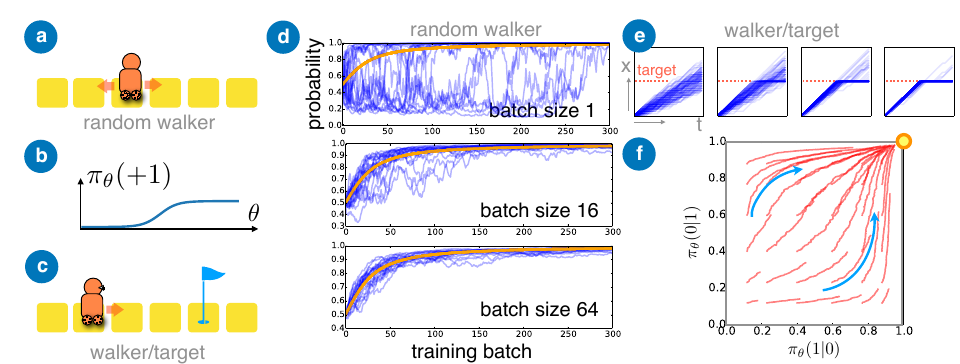
Figure 4: Simple illustrations of reinforcement learning. (a) A random walker moving either left or right in each time step, where the reward will be determined according to the distance covered to the right. (b) Dependence of the probability π (+ 1 ) for moving right on the policy parameter θ . (c) The walker / target example, θ where the walker has to learn to stop when on target. (d) Learning progress for the random walker, using policy gradient: we display the probability to move right (which should ideally converge to 1). Increasing batch sizes lead to smoother displayed for increasing learning progress (from left to right). Eventually, the walker learns to stop on target (rightmost panel). In this plot, the target was always placed at the same location x , though it has random locations during training. (f) Training on target, π θ ( 0 | 1 ) . The fixed point is indicated, representing the optimal